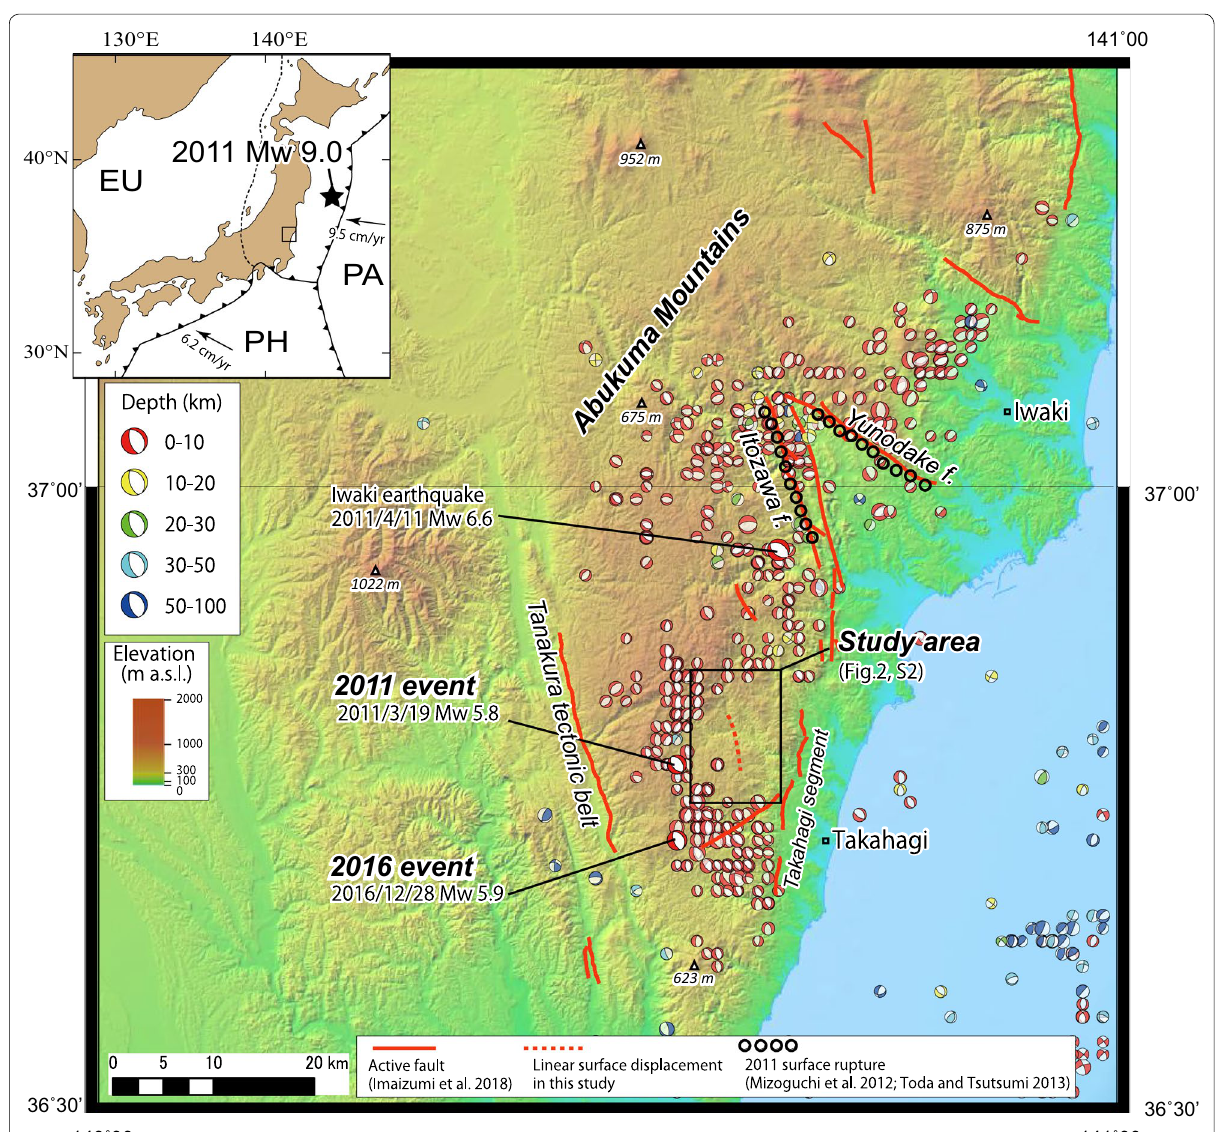
Fig. 1 Location map of the southern Abukuma Mountains, northeast Japan. The inset map shows plate boundaries, directions of absolute plate motion (arrows), and the locations of the main map (rectangle) and the epicenter of the Tohoku-Oki earthquake (star). Plate velocities are from Argus et al. (2011). EU, Eurasia plate; PA, Pacific plate; PH, Philippine Sea plate. The main map shows epicenters and focal mechanisms of events larger than M JMA 4.0 between 11 March 2011 and 28 December 2016 from the F-net catalog of the National Research Institute for Earth Science and Disaster Resilience. Red lines indicate active fault traces (after Imaizumi et al. 2018) and black circles indicate the surface rupture of the 2011 Iwaki earthquake (after Mizoguchi et al. 2012; Toda and Tsutsumi 2013). The base topographic map is originated from